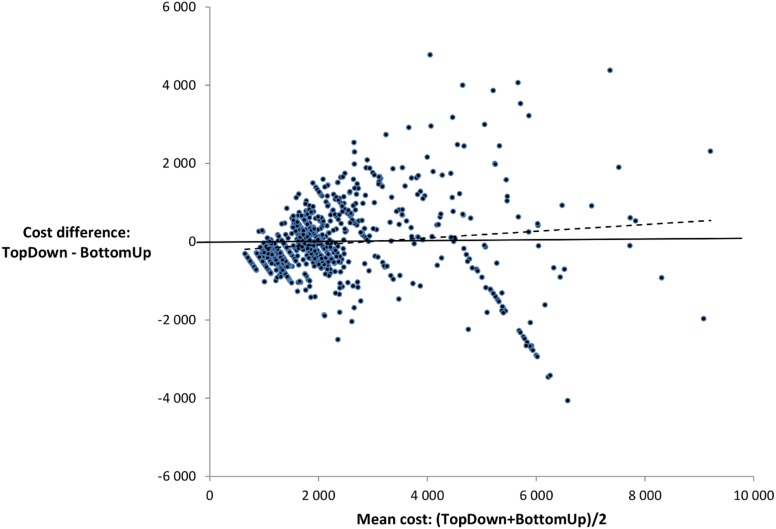
Bland and Altman plot of the difference between the costing methods against their mean.Each dot represents an individual procedure; the dotted line shows the ordinary least squares regression.